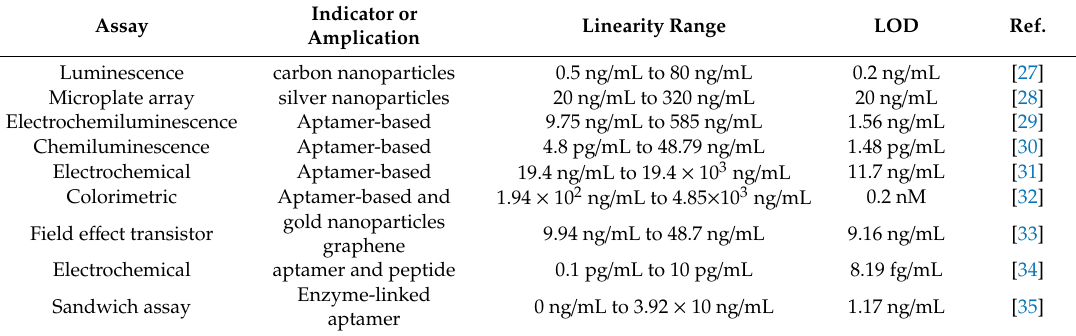
Table 1. Summary of other methods in recent years to detect IgE.